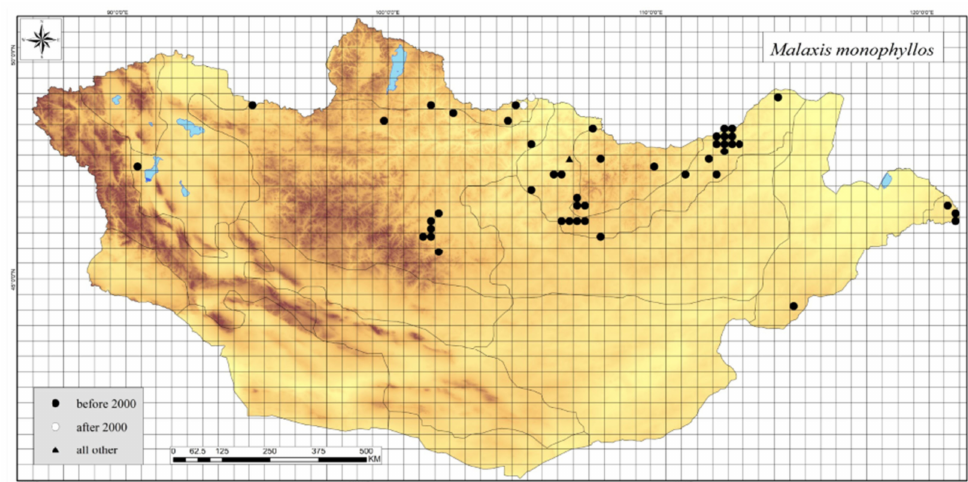
Figure A18. Distribution map of Malaxis monophyllos in Mongolia.